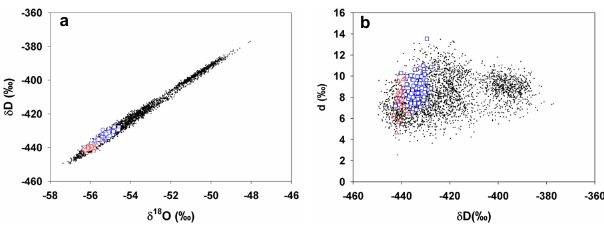
Figure 2. (a) δ D ice (‰) vs. δ 18 O ice (‰) and b ) d (deuterium excess ‰) vs. δ D ice (‰) for the clean (open blue squares) and dispersed (open red triangles) basal ice facies at EPICA Dome C, as compared to the ice from the 0–140ky interval (black dots, Stenni et al., 2010). See text for details.